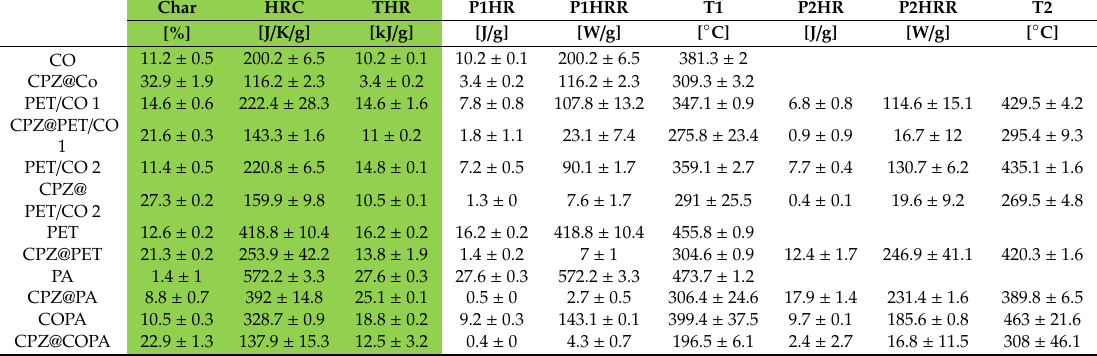
Table A2. Full MCC date. Figure 5 is based on the green